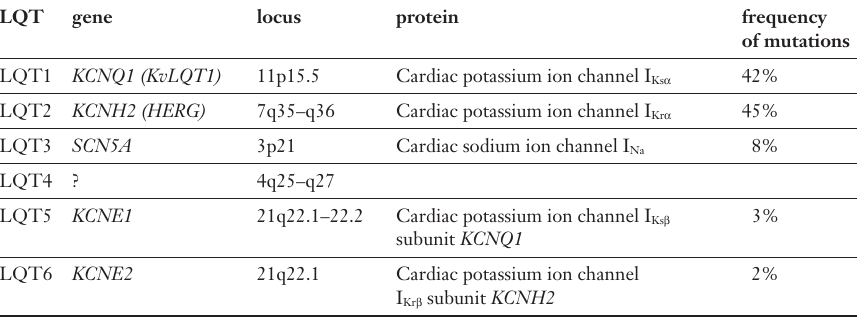
LQTS genes, proteins and frequency of